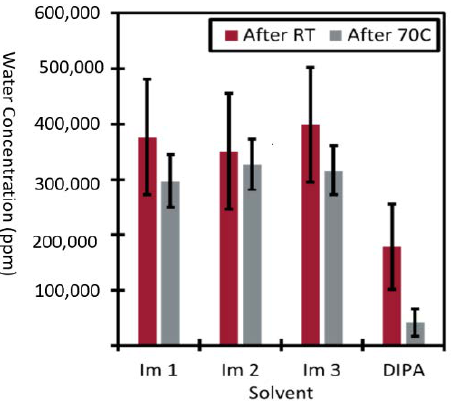
Figure 1. The amount of water present in the solvent after contact with the brine phase and after phase separation at 70 °C as determined by a KF Titrator. The error bars represent one standard deviation among at least three trials.